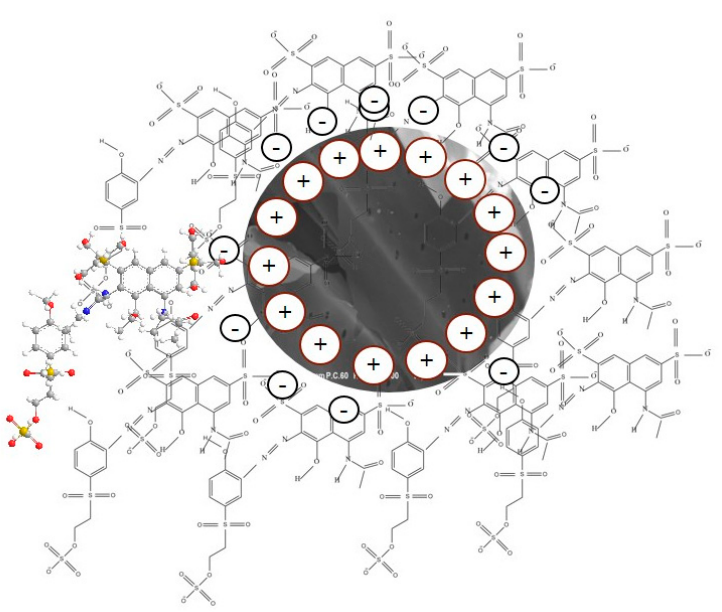
Figure 12. Mechanism of the adsorption of RBV-5R on SCB in aqueous medium.